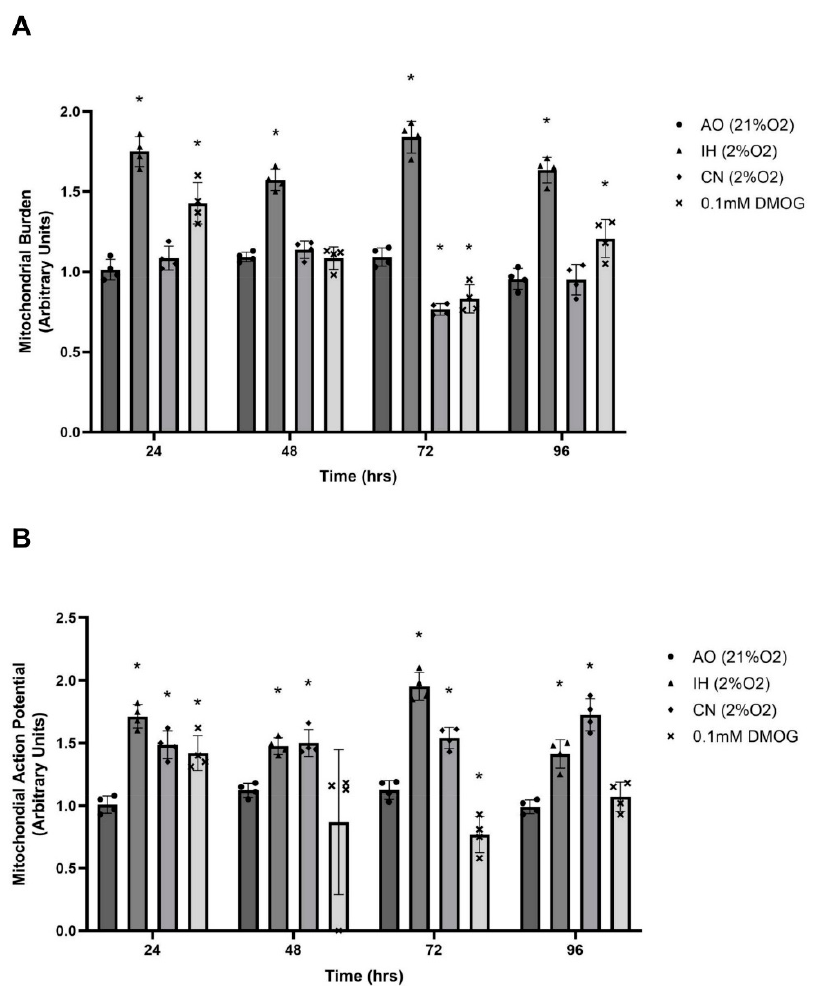
Figure 6. Mitochondrial burden and action potential of PC12 cells cultured at different oxygen levels and with DMOG. PC12 cells were cultured in air oxygen (AO), intermittent hypoxia (IH) or continuous normoxia (CN) or with DMOG (0.1 mM) in AO for a 96 h time-course. ( A ) MitoTracker Green fluorescence was measured by flow cytometry following labelling and incubation. Cells in IH had a significantly higher mitochondrial burden, while cells in CN and with DMOG had a similar mitochondrial burden compared to those in AO in the first 48 h, with a significant reduction at 72 h. ( B ) MitoTracker Red fluorescence was measured by flow cytometry following labelling and incubation. The mitochondrial action potentials were significantly increased under IH and CN incubation. DMOG significantly increased the mitochondrial action potentials at 24 h but reduced it at 72 h. Data are presented as normalised mean fluorescence intensity ± S.E.M, n = 4. Statistical significance of the assay was evaluated using one-way ANOVA with Tukey post hoc corrections. * indicates significant difference in comparison to AO at each time point ( p < 0.05).